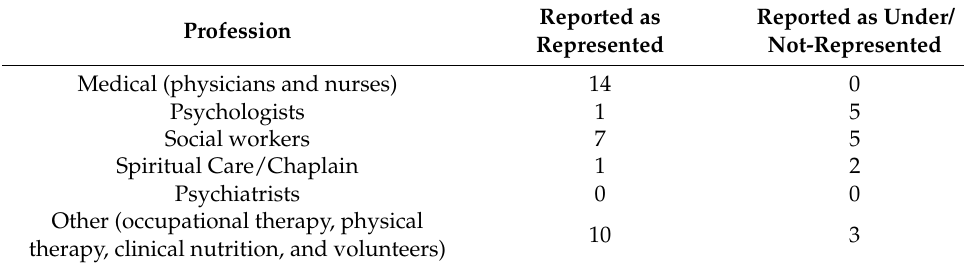
Table 2. Reported